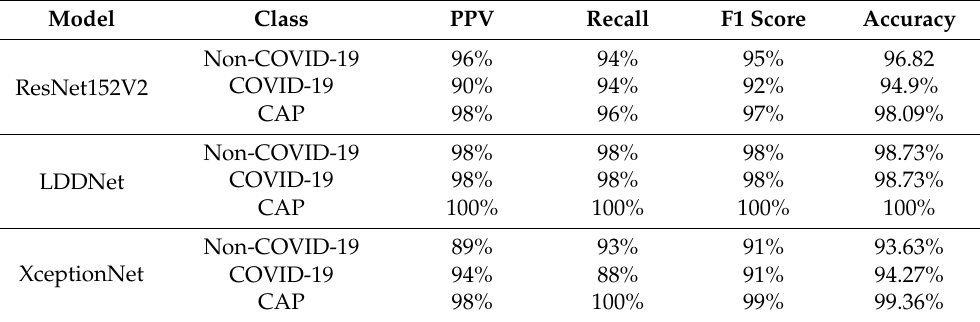
Table 7. Comparison of different DL models for the SGD